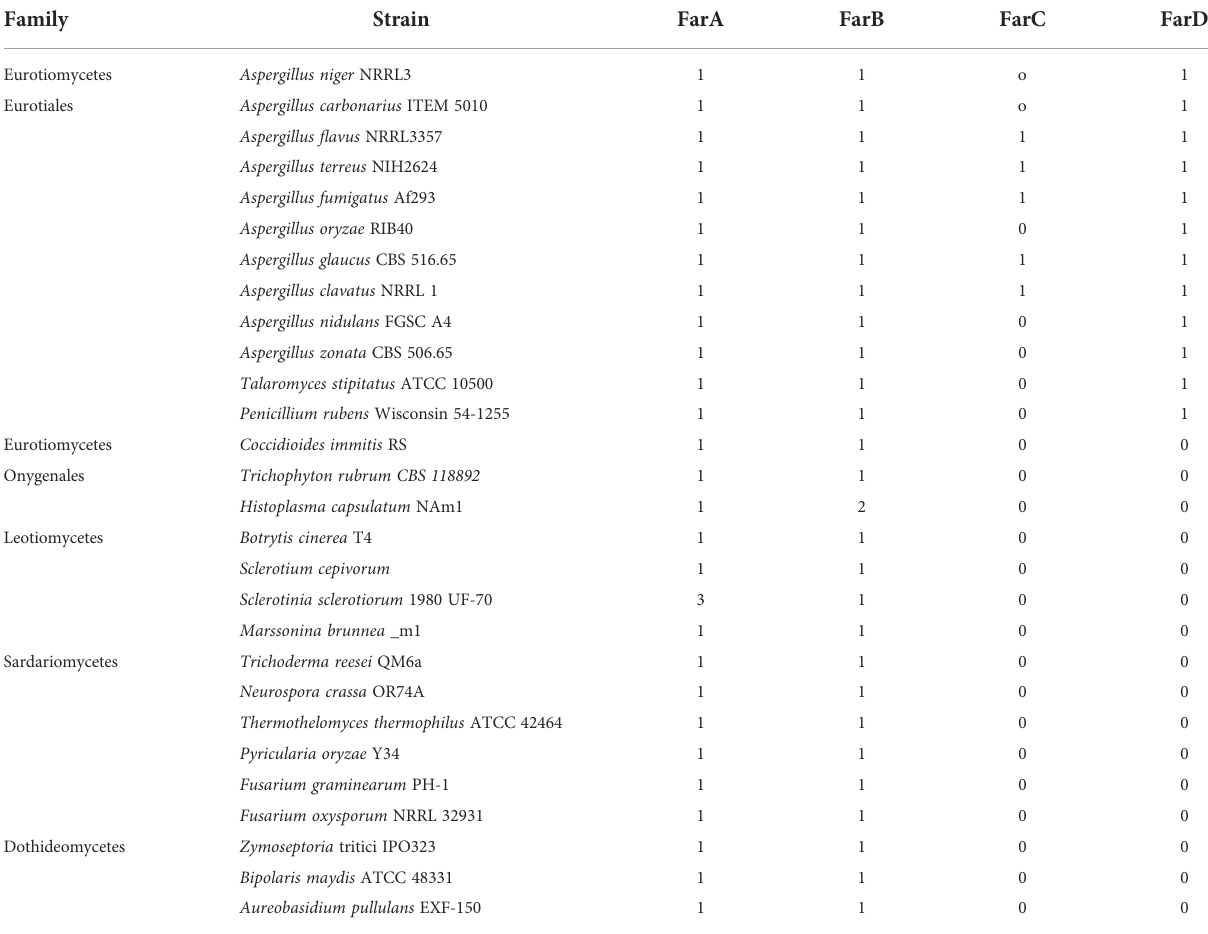
TABLE 3 Presence of FarA, FarB and Far-like protens TF in 28 Pezizomycotina species.